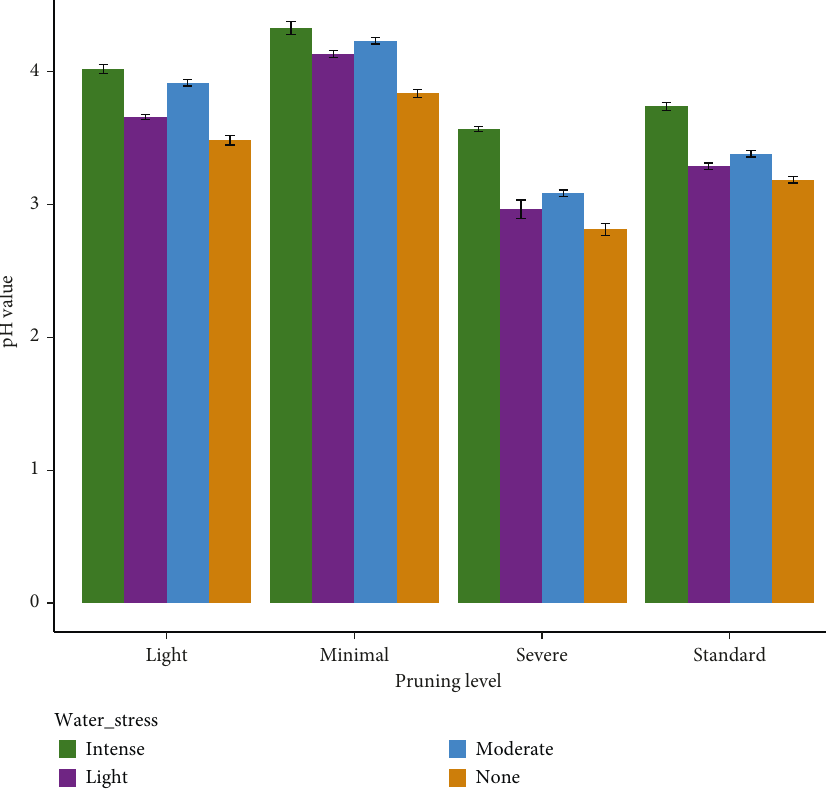
Figure 10: Response of berry juice pH to interactive effect of pruning level and post-veraison water